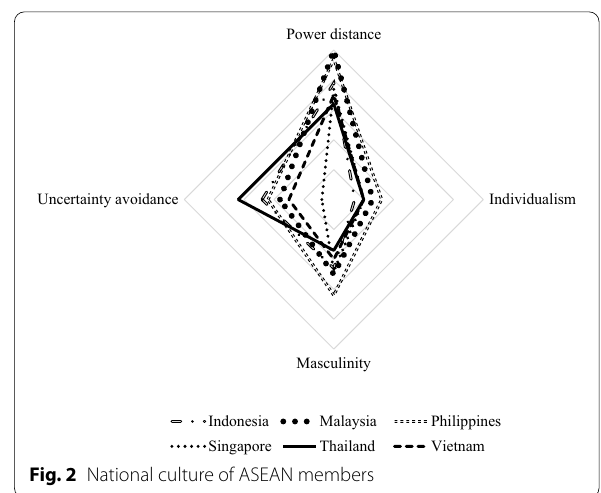
Fig. 2 National culture of ASEAN